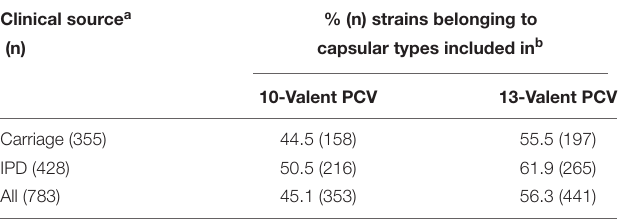
TABLE 1 | Distribution of capsular types included in pneumococcal conjugate vaccines currently available among 783 Streptococcus pneumoniae isolates according to the clinical source.